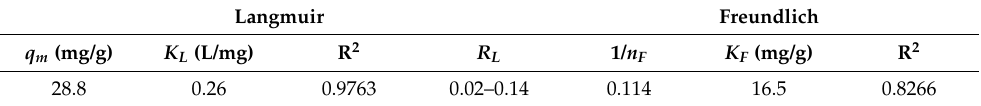
Figure 7. ( a ) Langmuir and ( b ) Freundlich isotherm model plots for adsorption of dyes onto the banana peel (pH: 7, C i : 25, 50, 75, 100, 150 and 200 mg/L, M ads : 0.5 g, t : 60 min, T: 25 ◦ C, S: 180 rpm, solution volume: 250 mL). Table 1. Adsorption isotherm parameters for dye adsorption onto the banana peel.